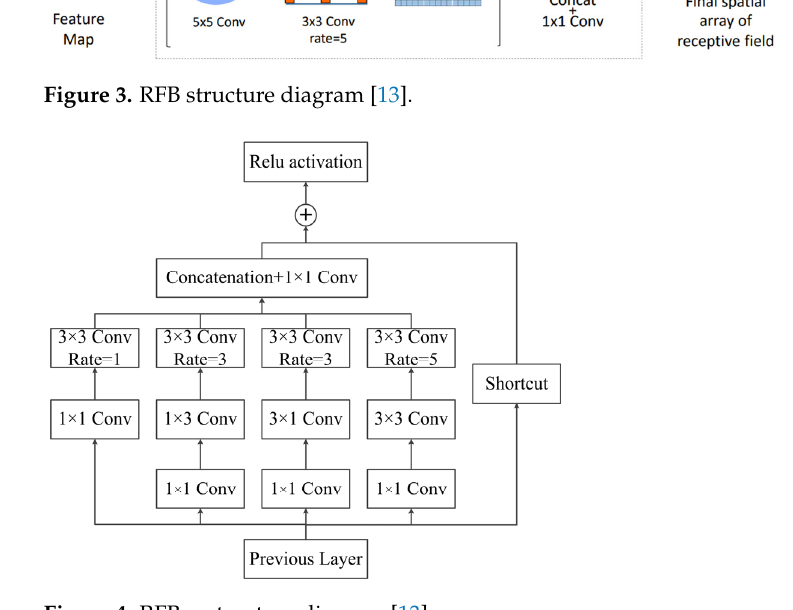
Figure 4. RFB_s structure diagram [13].